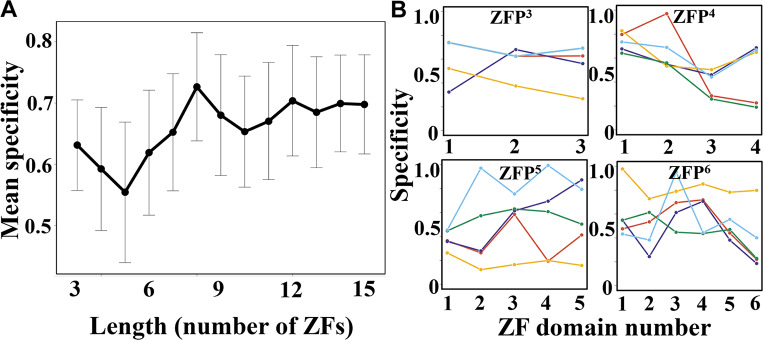
Binding specificity in C2H2-type tandem zinc-fingers.(A) Mean DNA binding specificity is shown for human C2H2-type tandem zinc finger proteins (ZFPs) of different lengths, comprising 3 (ZFP3) to 15 (ZFP15) zinc finger (ZF) domains. (B) The binding specificity of each zinc-finger domain for ZFPs comprising 3 (ZFP3) to 6 (ZFP6) ZF domains. The colours in each panel correspond to the five selected proteins shown in Fig 2.